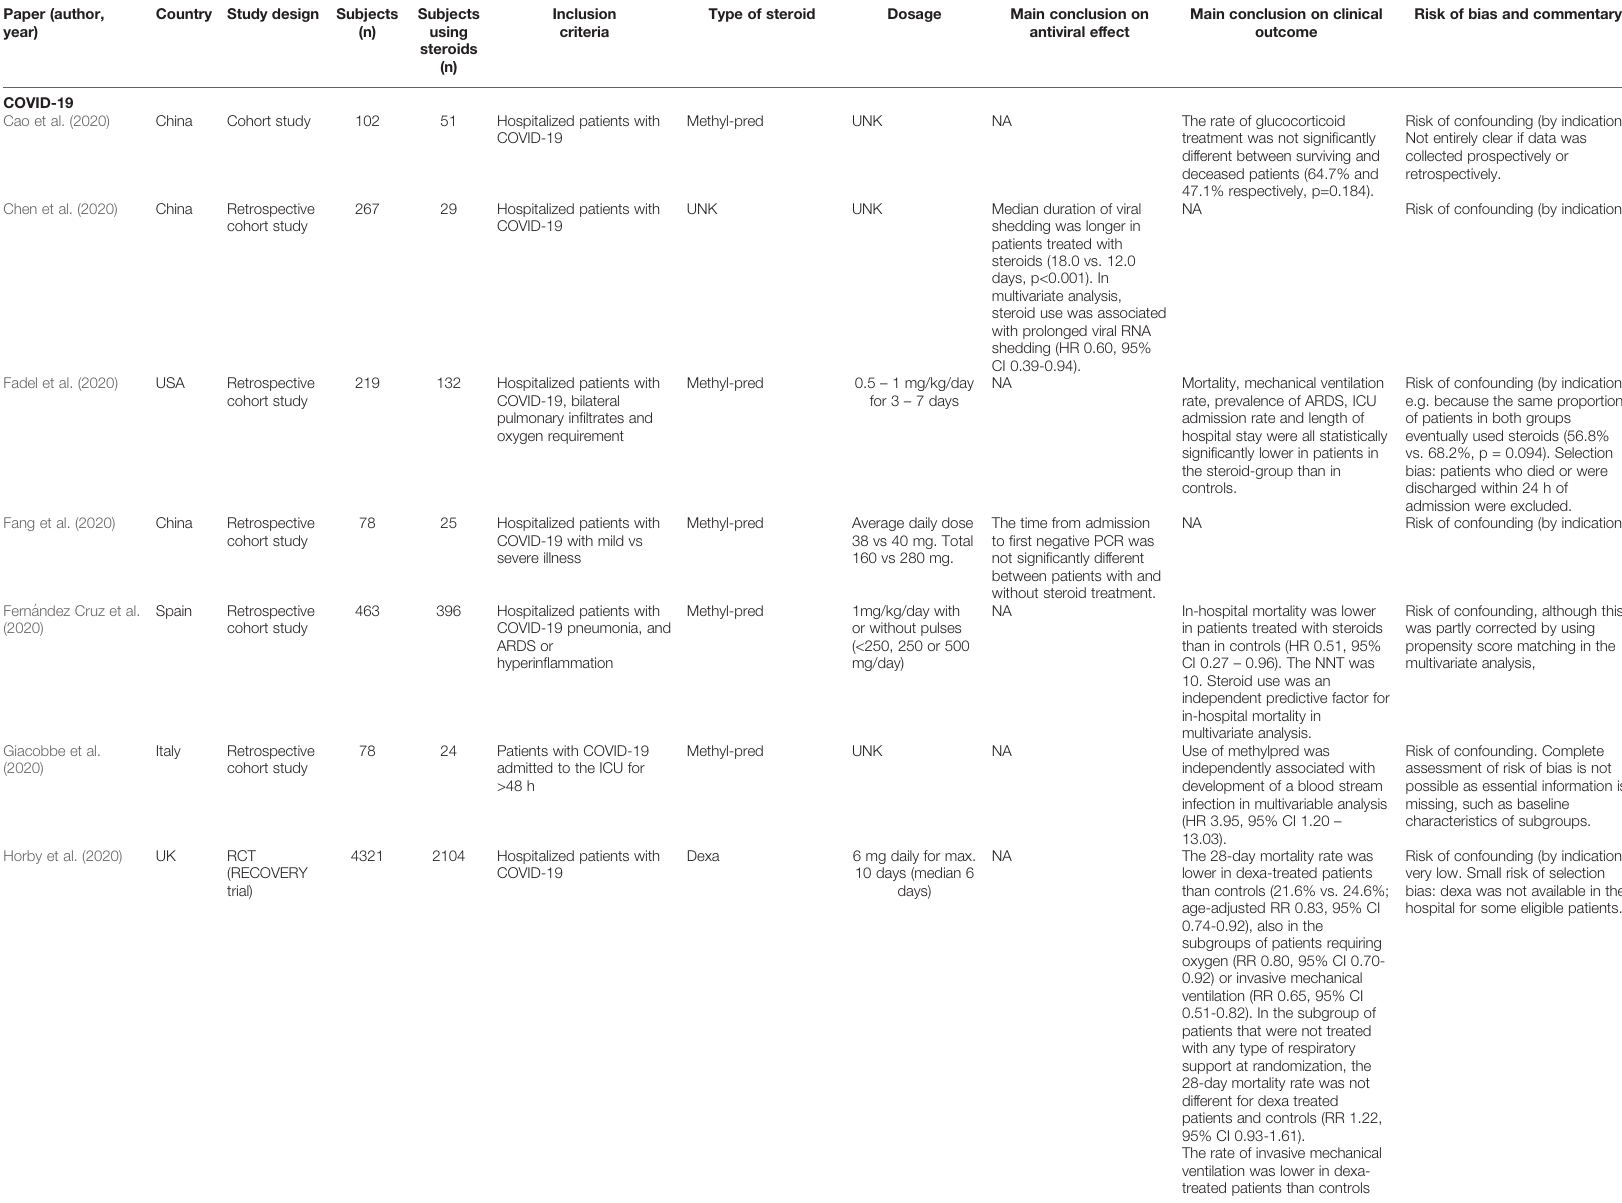
TABLE 2 | Overview of clinical studies of corticosteroids in the treatment of patients with COVID-19, SARS and MERS. Paper (author, year)